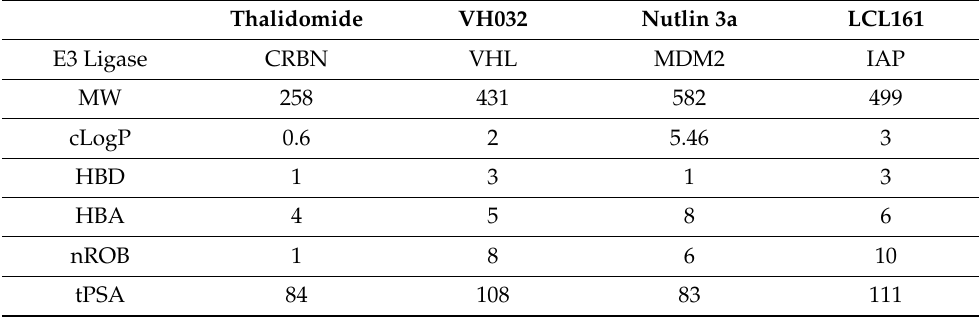
Table 3. Comparison of properties between the most commonly used